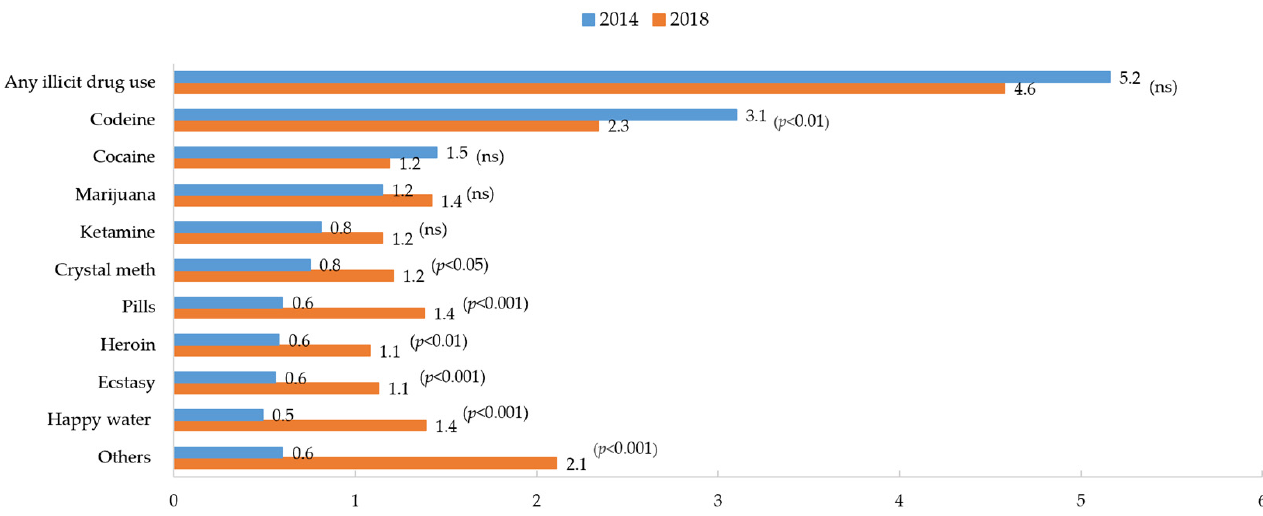
Figure 2. Trends in prevalence of lifetime use of 10 nominated illicit drugs from 2014 to 2018. Note. Only significant p values are shown, with ‘ns’ meaning p values are not significant. The level of significance was set at p < 0.05.